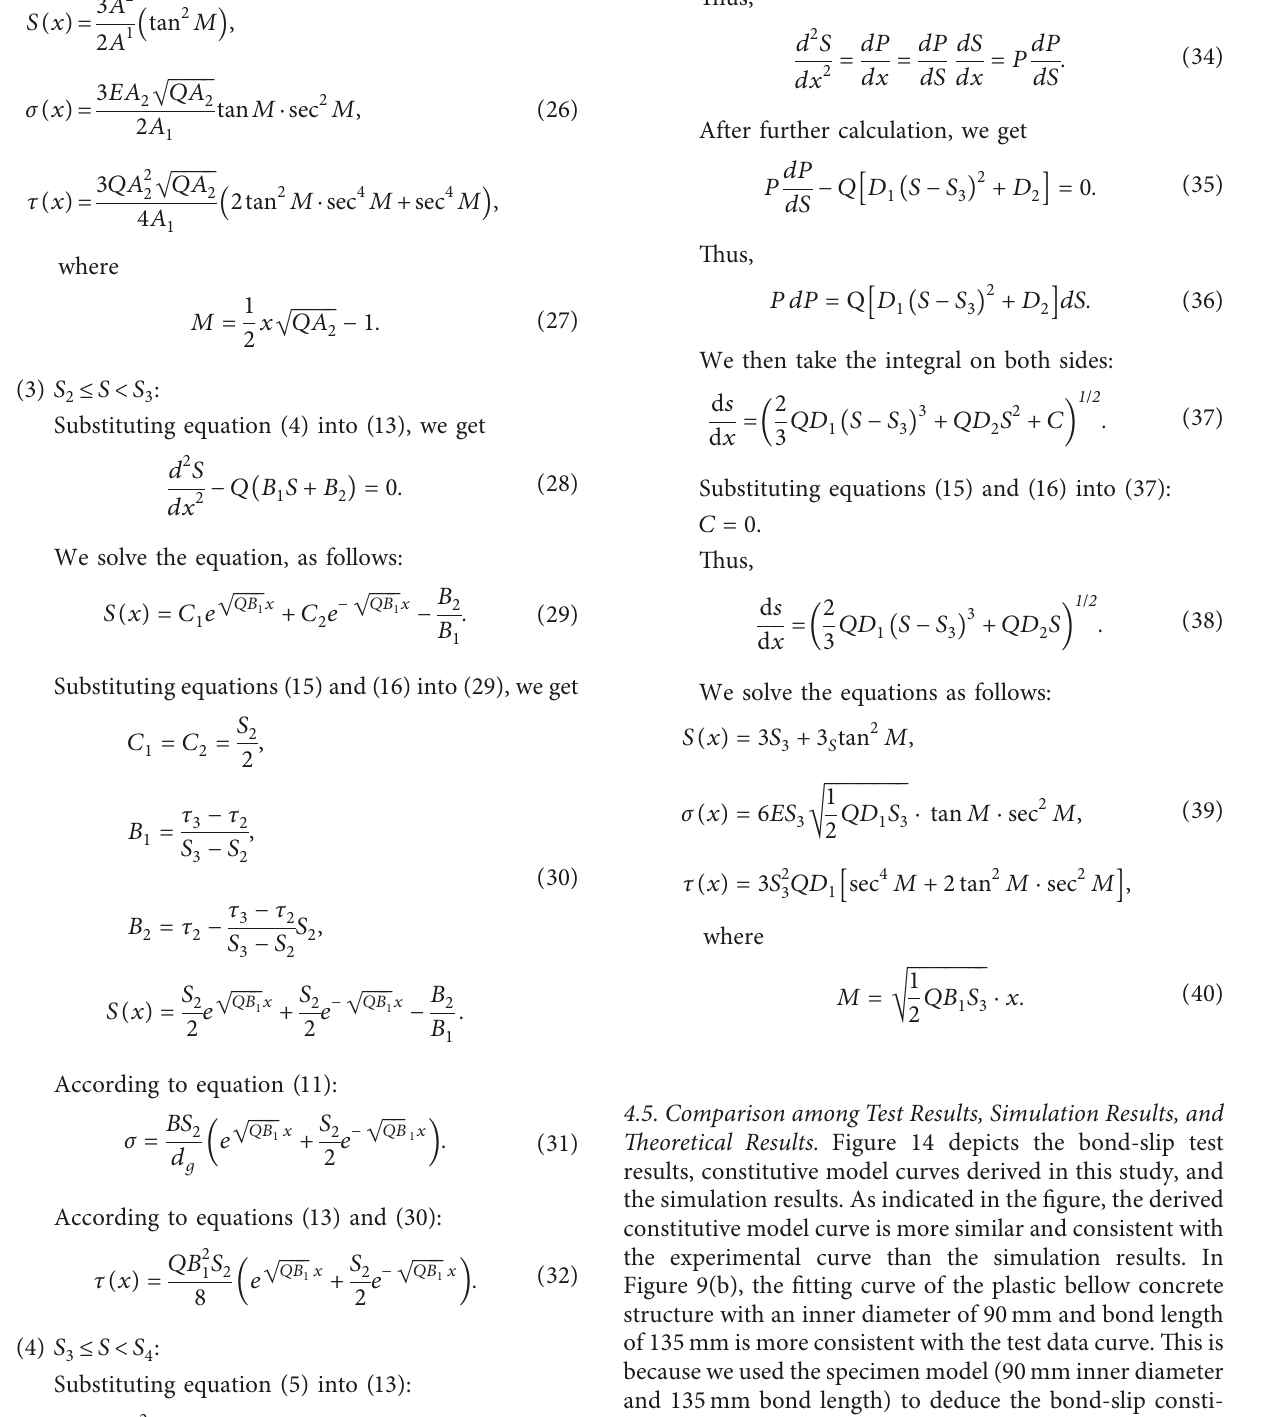
structure with an inner diameter of 90 mm and bond